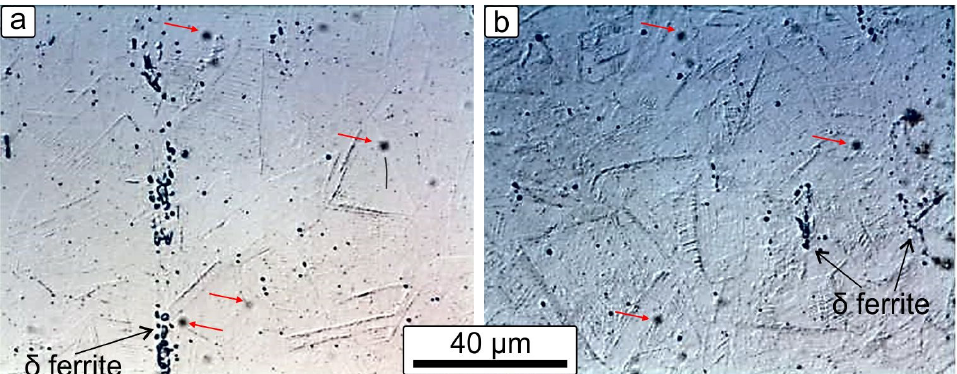
Figure 2. Microstructure of ( a ) SS 316L and ( b ) SS 304L used.